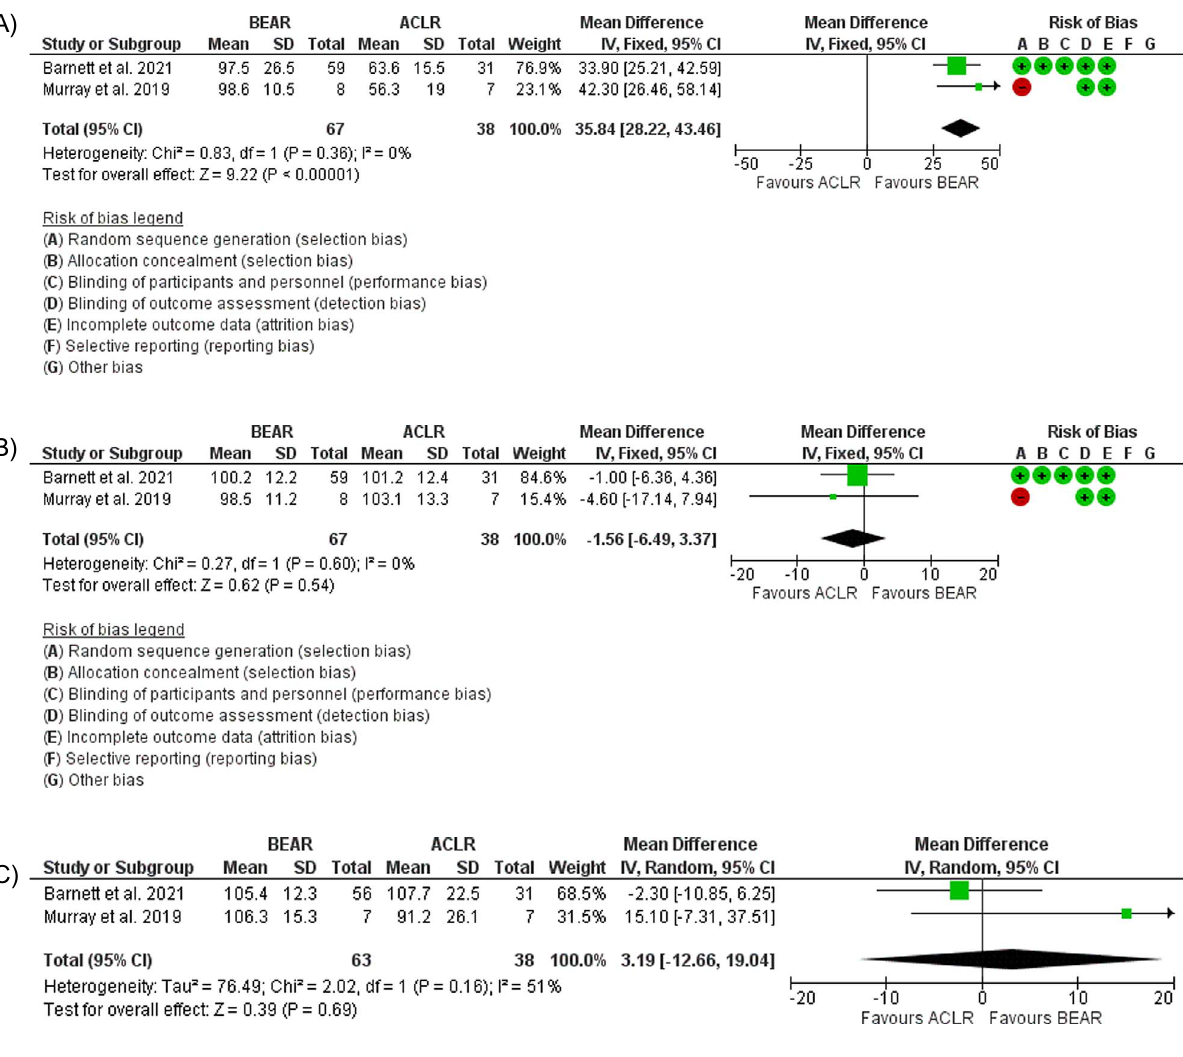
Figure 6. (A) Forest plot showing the hamstrings strength 2 years postoperatively in ACLR and BEAR. (B) Forest plot showing the quadriceps strength 2 years postoperatively in ACLR and BEAR. (C) Forest plot showing the hip abductors strengths 2 years postoperatively in ACLR and